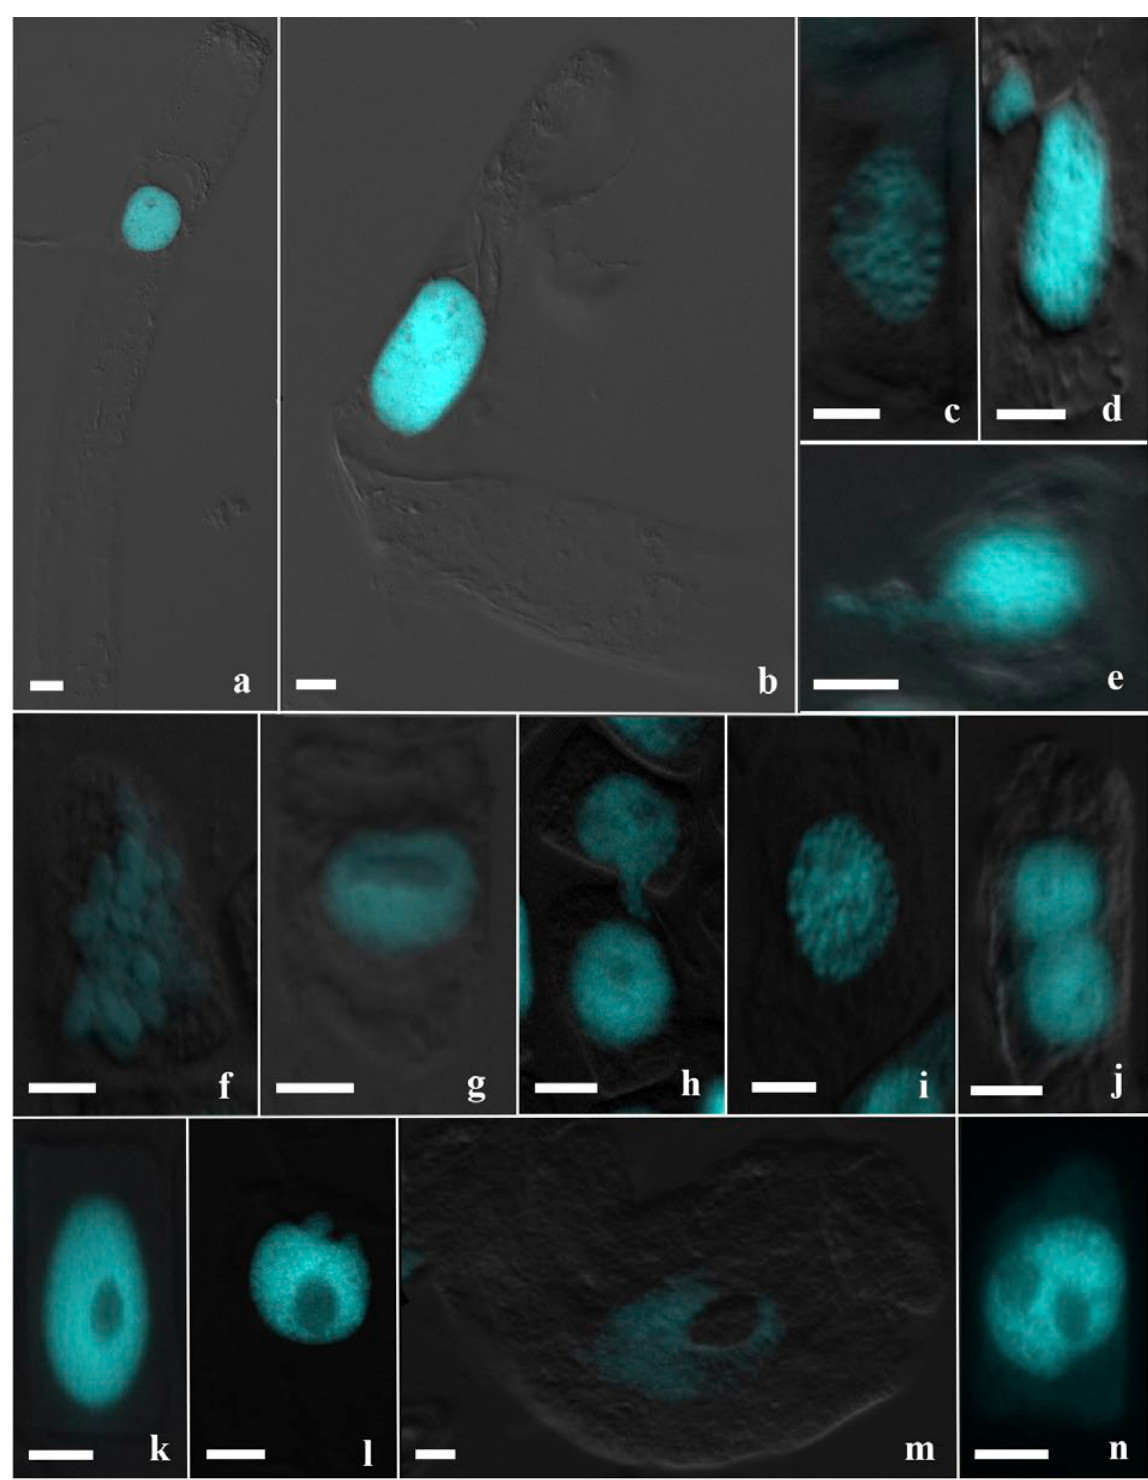
Fig. 4. Chromosomal aberrations induced by extract of C. viminale on A. cepa . a: giant cell; b: giant cell with cytoplasmic shrinkage; c: for- mation of apoptotic bodies in the nucleus; d: bridged binucleate cell; e: nuclear extrusion; f: apoptotic body formation; g: nuclear and cyto- plasmic lesions; h: cytomictic transfer of nuclear material; i: nuclear disintegration; j: binucleate cell; k: nuclear lesion; l: double budding and lesion; m: giant cell showing nuclear disintegration and lesion; n: double nuclear lesions; Bar: 10